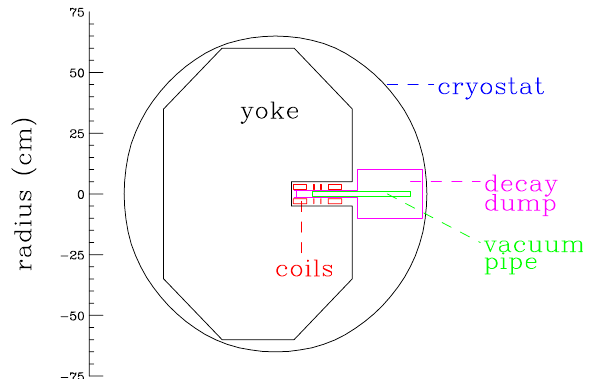
FIG. 57. (Color) Cross section of an unsuccessful alternative high field C magnet with open